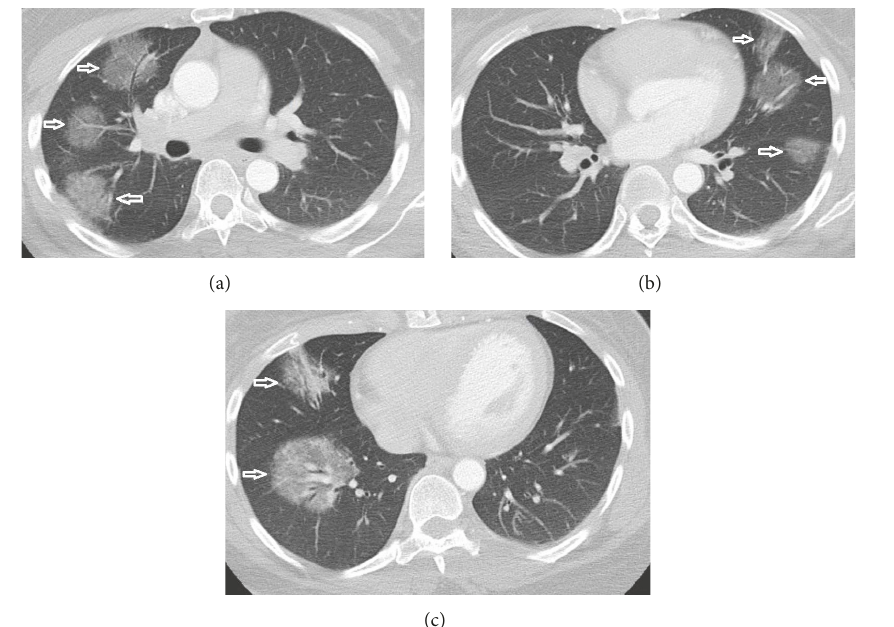
Figure 2: Axial contrast-enhanced CT obtained at different levels (a, b, c), demonstrating bilateral mass-like ground-glass opacities in a peribronchovascular distribution (arrows) with air-bronchograms and vessels seen coursing